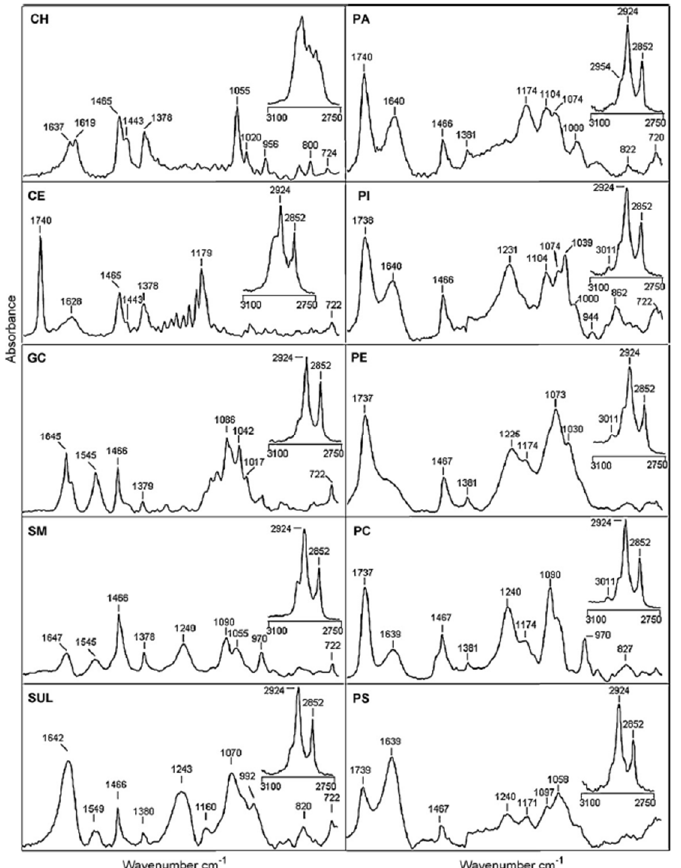
Figure 4. IR spectra of neutral lipids, sphingolipids, and phospholipids from 1800 to 700 cm − 1 and 3100 to 2750 cm − 1 (insets): cholesterol (CH), cholesterol ester (CE), galactocerobrosides (GC), sphingomyelin (SM), sulfatides (SUL), phosphatidic acid (PA), phosphatidylinositol (PI), phosphatidylethanolamine (PE), phosphatidylcholine (PC), and phosphatidylserine (PS) [reprinted with permission from [103]].